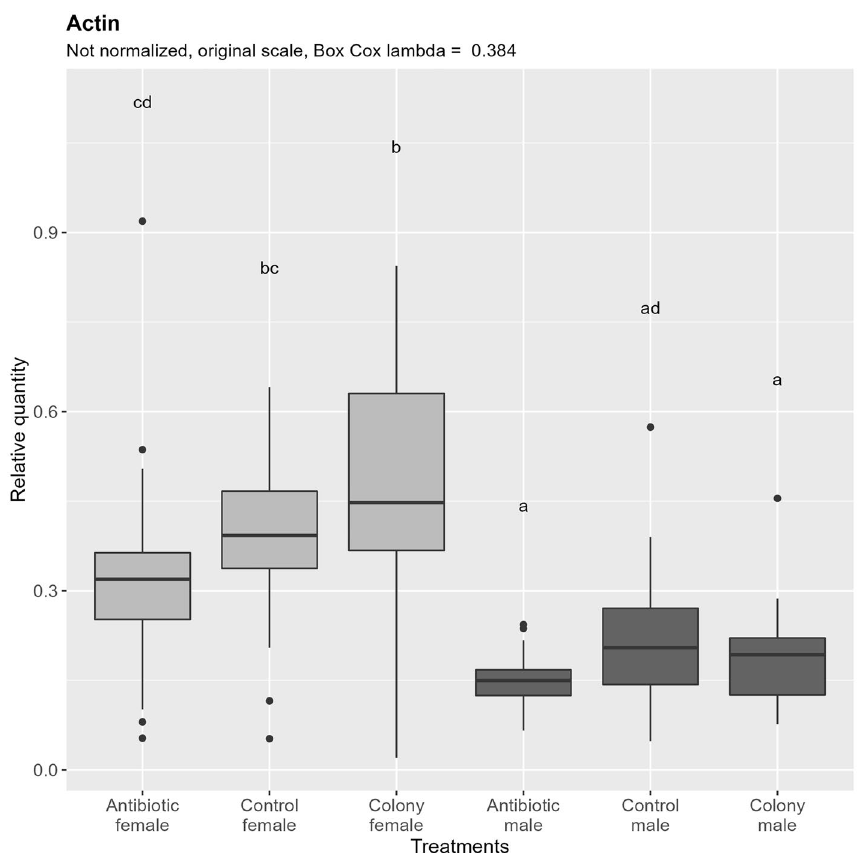
Figure 3. Relative quantification of nuclear DNA (Actin target) across the treatment groups. Note that the relative quantity is shown on the original scale for more intuitive interpretation, while the ANOVA was performed on the Box Cox transformed data. Values with the same letter are not significantly different (alpha = 0.05, Tukey’s HSD test). Boxes represent the data between 25 and 75th percentile, horizontal line within the box represents median, and dots represent the outliers. A data point was considered an outlier as per the standard definition of the R package ggplot2 (when the data point (x) is either lower than Q1—1.5 * IQR (interquartile range) or greater than Q3 + 1.5 * IQR). Vertical lines extending the boxes (whiskers) are drawn using standard ggplot2 function and are calculated using the following formulas: upper whisker =